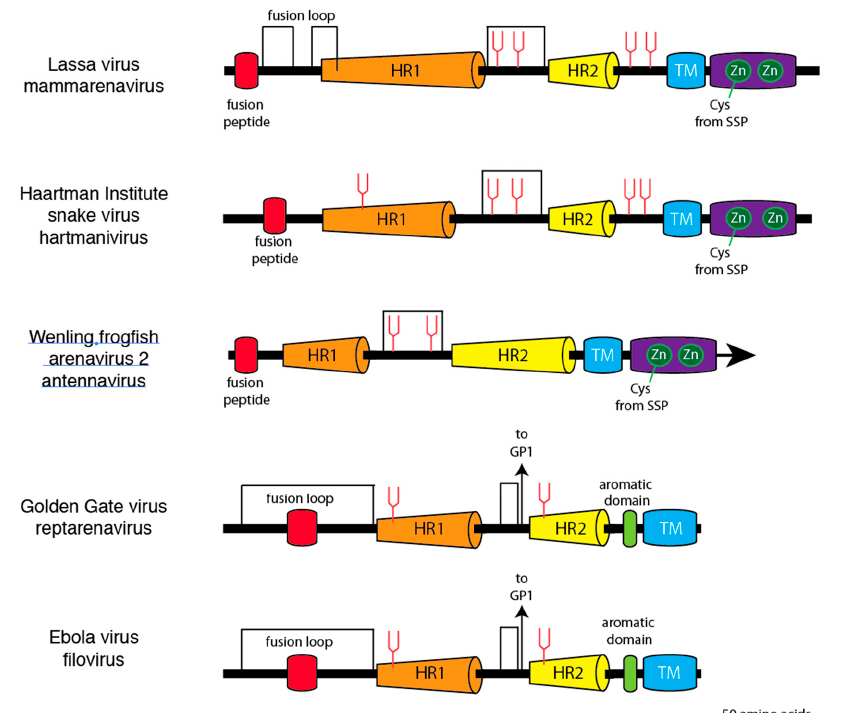
Figure 3. Linear models of glycoprotein 2 from representative members of the four arenavirus genera and a filovirus. Coloring and abbreviations as in Figure 1. Zn in green circle represents zinc-binding domains. A cysteine (Cys) from the stable signal peptide (SSP) coordinates with the first zinc-binding domain in Lassa virus, Haartman Institute snake virus, and W ē nl ǐ ng frogfish arenavirus-2. Arrows indicate cysteine linkages to glycoprotein 1 (GP1) of Golden Gate virus and Ebola virus.